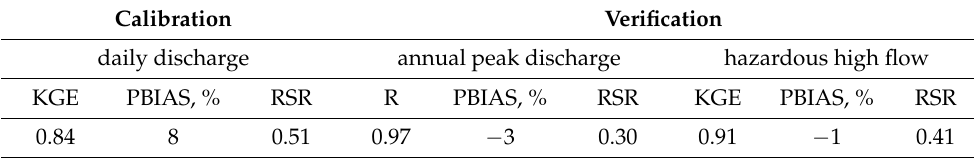
Table 3. Model performance of the Iya River at the Tulun gauge over the period 1970–2019.